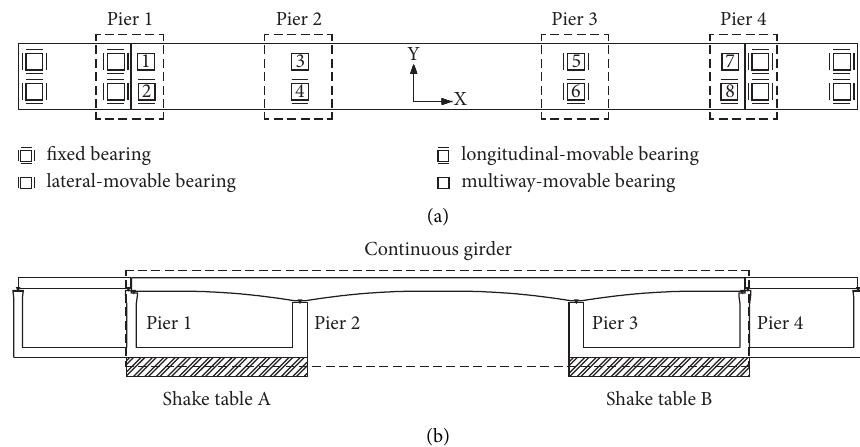
Figure 11: Spherical bearings’ arrangement in the experimental HSRB (continuous girder) specimen for (a) plane view and (b) vertical view.